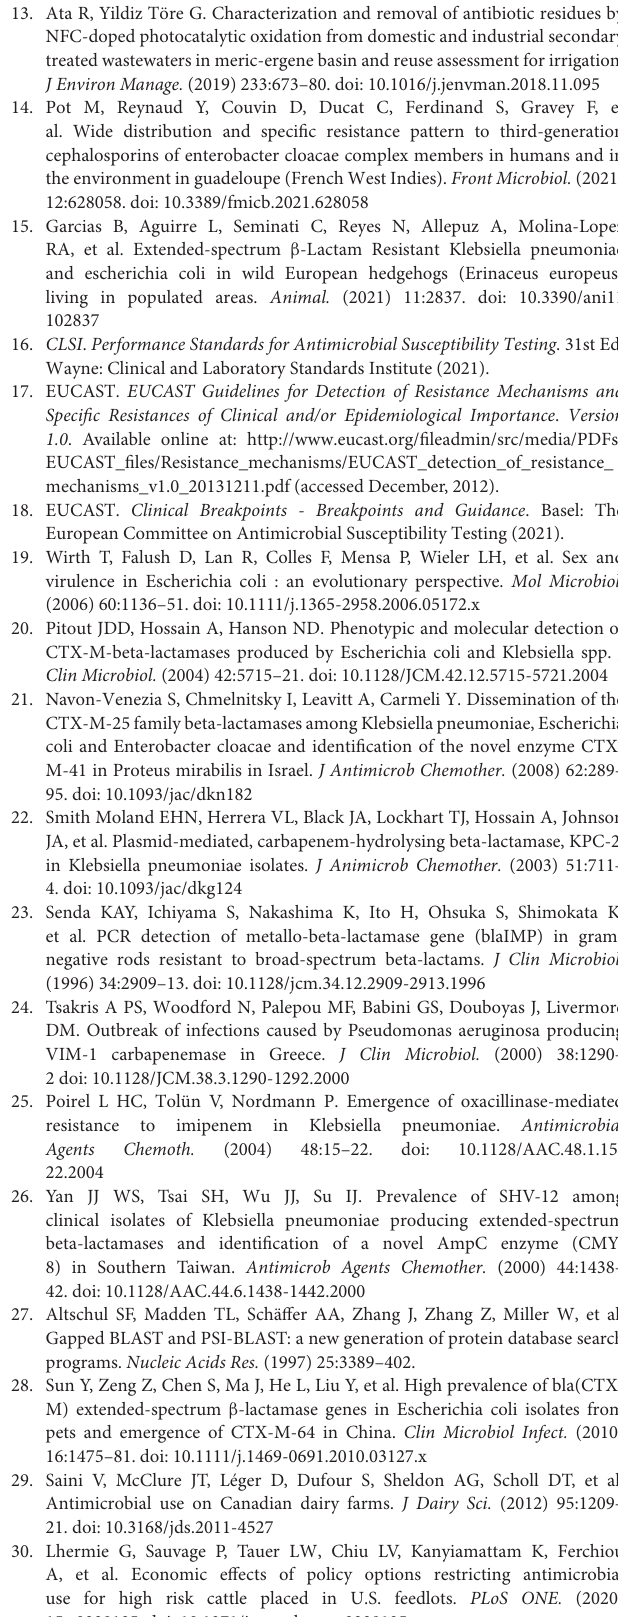
Table‘ of Contents. doi: 10.1128/CMR.00036-08 41. Goodman KE, Simner PJ, Tamma PD, Milstone AM. Infection